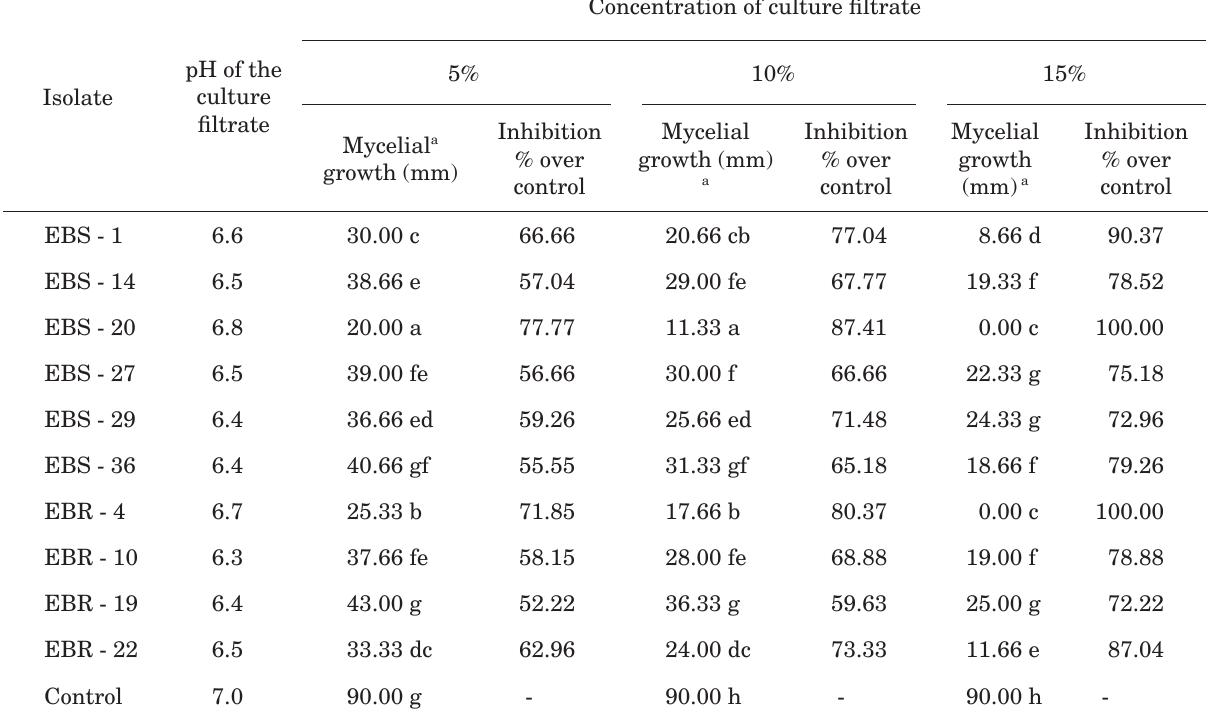
Concentration of culture